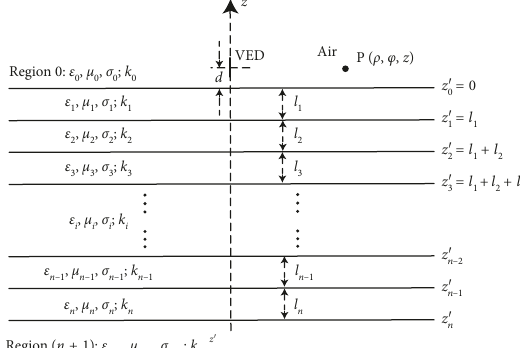
Figure 2: Geometrical profile of the horizontal N -layered